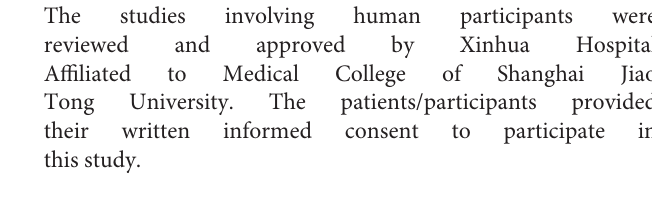
improving the ocular surface health. Therefore, IPL can be used as an effective regimen for the treatment of MGD. The pertinent lipid changes include LPC, OAHFA, TG, Cer, etc. in patients with MGD can be used as the biomarkers for taking personalized medical methods for